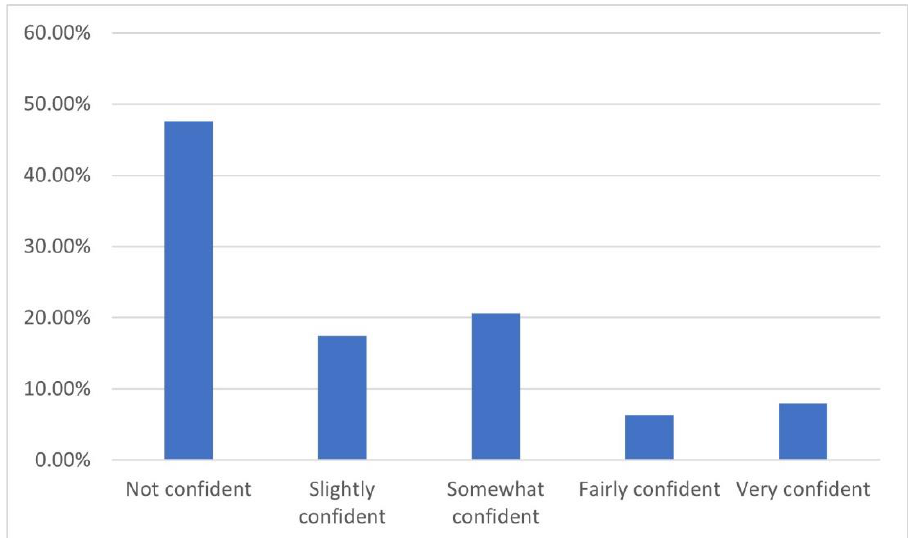
Confidence in the Transition to Online Mode